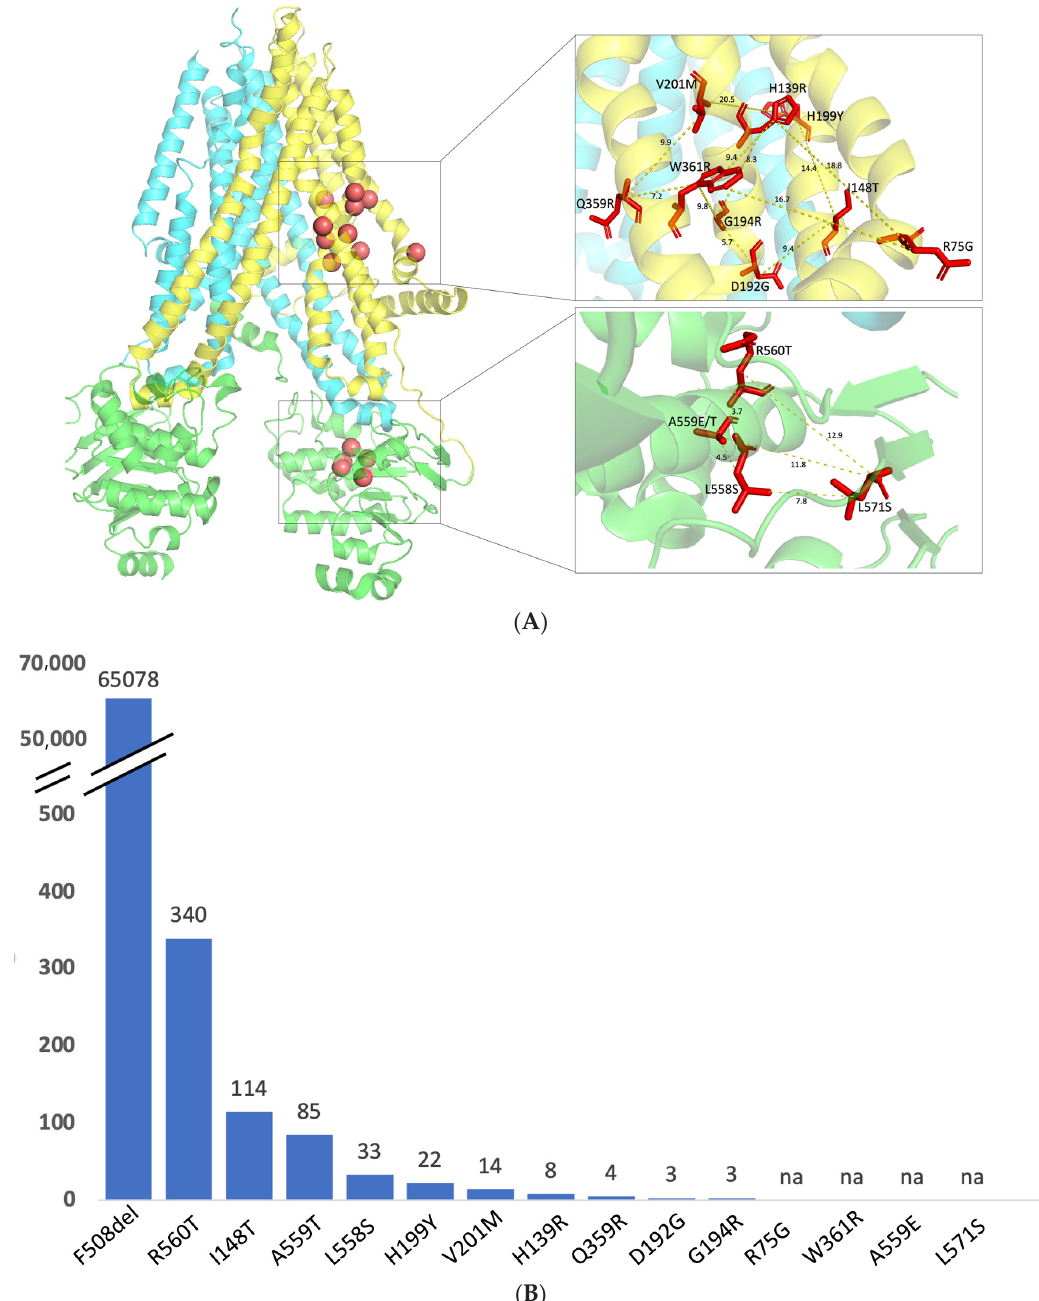
Figure 2. Location and incidence of the variants under study. ( A ) CFTR structure (PDB: 5UAK) with TMD1 in yellow, TMD2 in blue, and NBD1 and NBD2 in green. The red spheres indicate the position of the variants analyzed—R75G, H139R, I148T, D192G, G194R, H199Y, V201M, Q359R and W361R are localized in TMD1, while A559T, A559E, L558S, and L571S are found in NBD1. Insets identify in red sticks the original residues and the distances between those residues. ( B ) Number of individuals with CF listed in CFTR2 that carry the variants under study according to the most recent update. “na”—variant not listed in CFTR2.